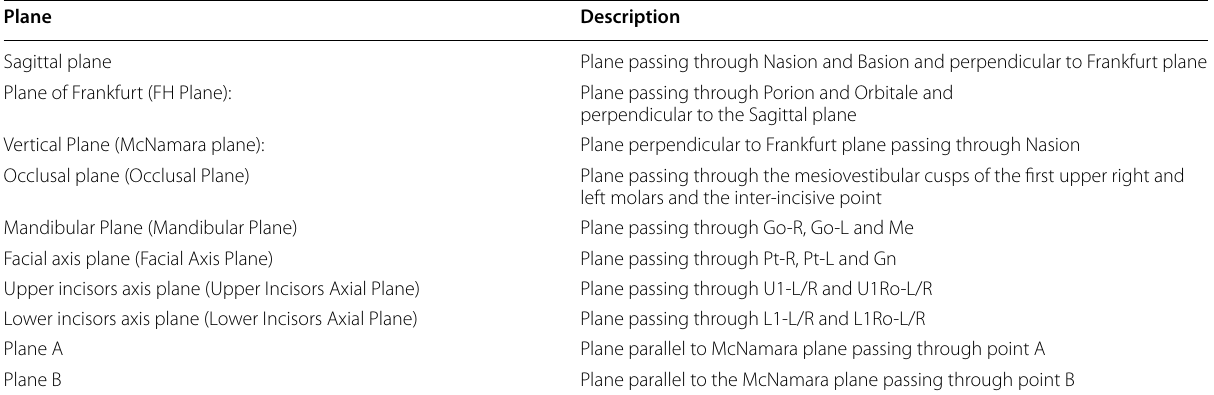
Table 3 Cephalometric reference planes